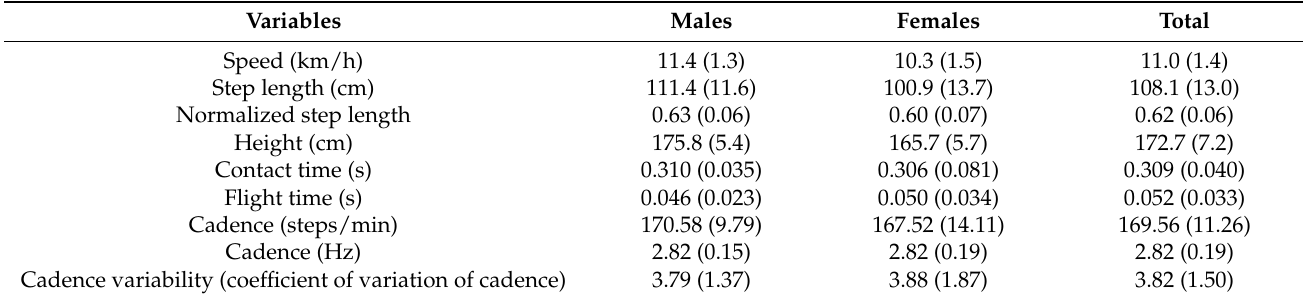
Table 2. Values of spatiotemporal gait parameters measured with the Optogait system. Data are reported as mean